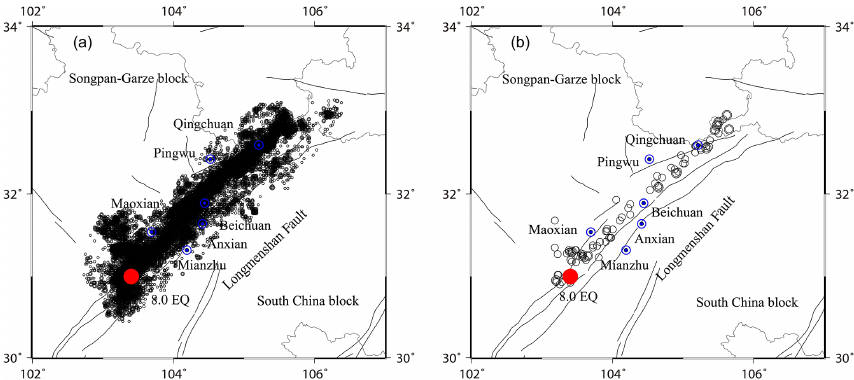
Figure 3. Spatial distribution of epicenters of the Wenchuan earthquake sequence with (a) M >0 and (b) M ≥ 5 . 0 from 12 May 2008 to 31 December 2016. The mainshock on 12 May 2008 is labeled by a red solid